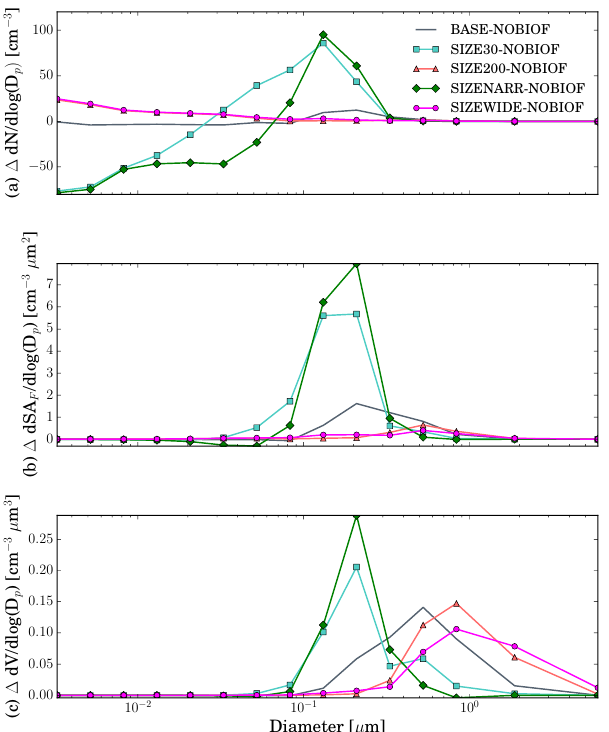
Figure 9. Globally averaged (a) change in number distribution, (b) change in Fuchs surface area distribution, and (c) change volume distribution for BASE–NOBIOF, SIZE30–NOBIOF, SIZE200– NOBIOF, SIZENARR–NOBIOF, and SIZEWIDE–NOBIOF com- parisons. The subtractions isolate the contributions of biofuel emis- sions to each